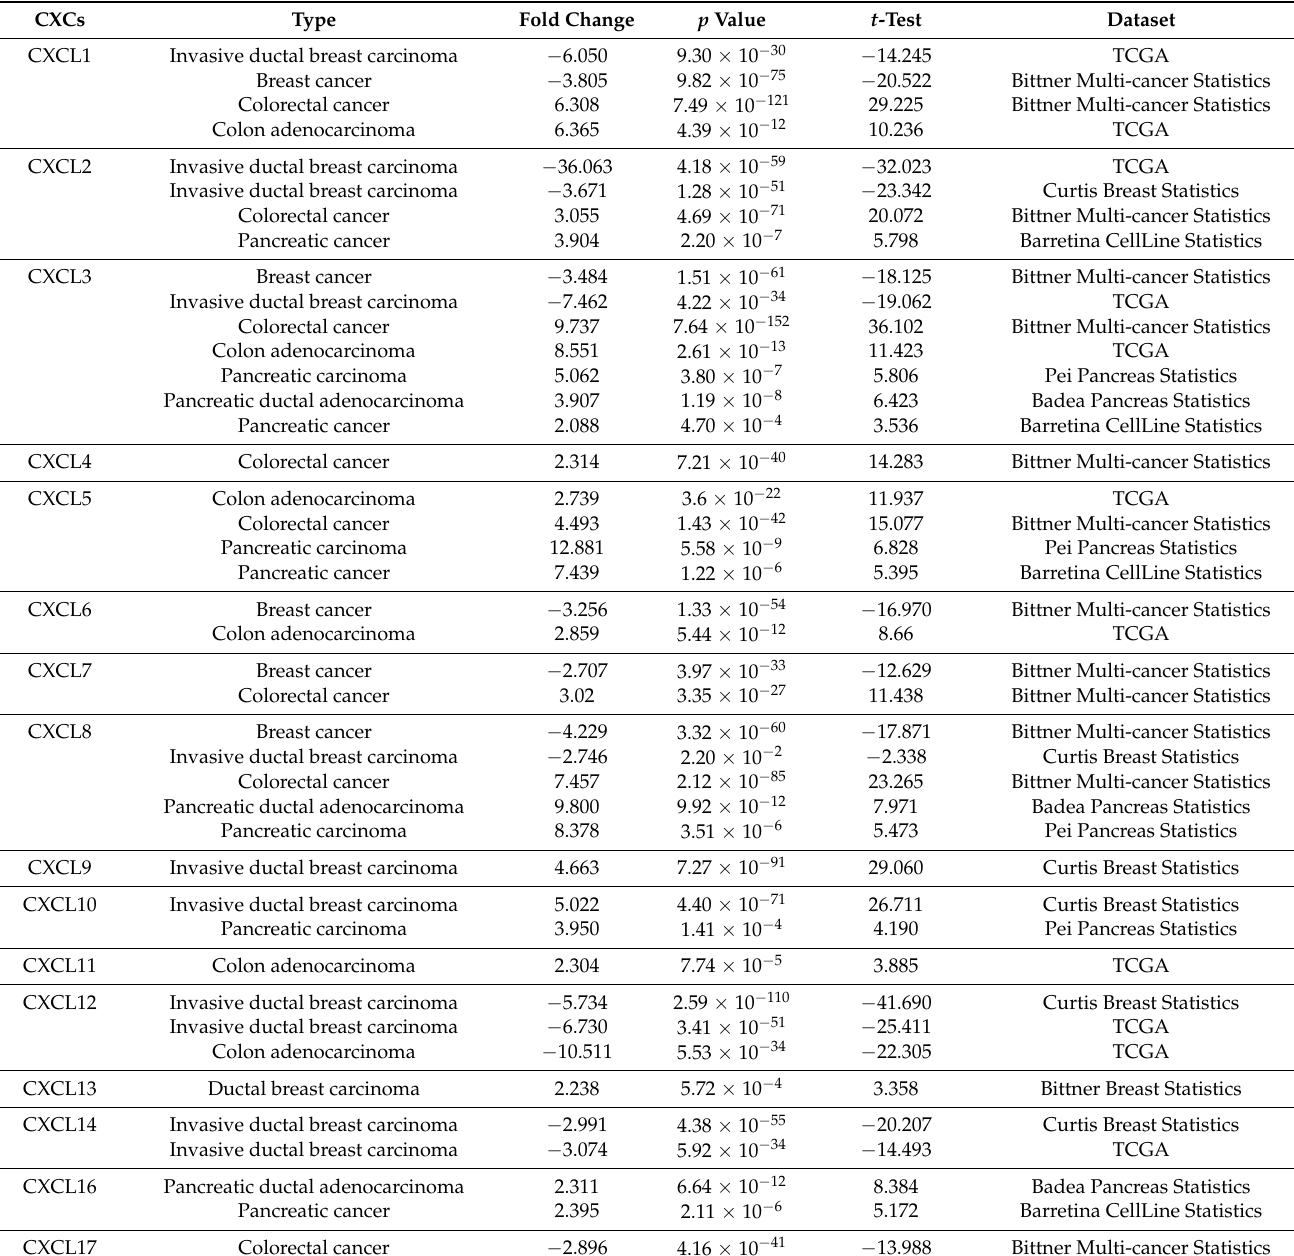
Table 1. Differential expression of CXCs in datasets of